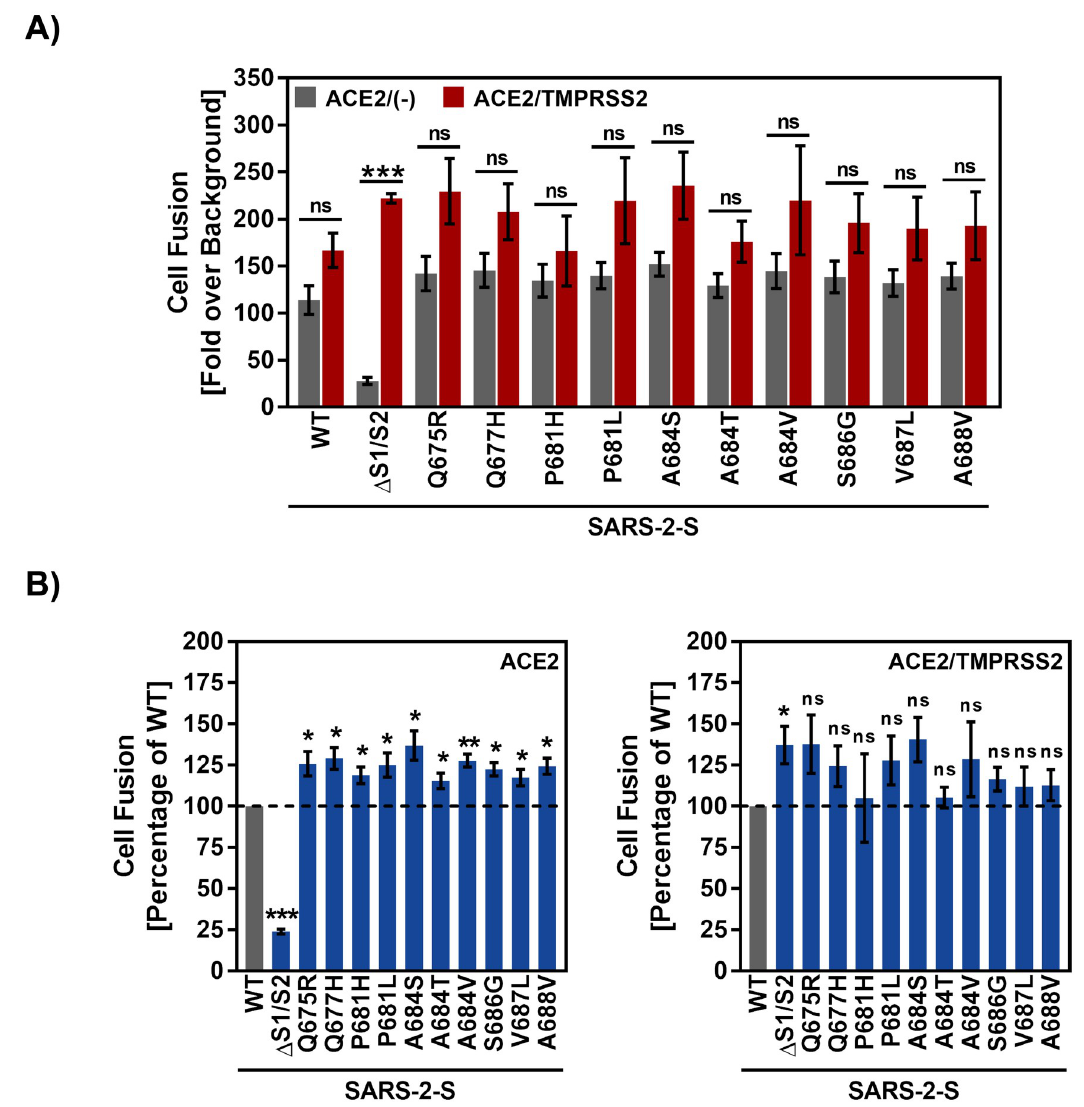
Fig 3. SARS-CoV-2 mutants mediate robust cell-cell fusion. A) Effector cells cotransfected with Vp16-Gal4 transactivator plasmid and pCG1 empty vector (negative control) or expression plasmids for the indicated S proteins were co-cultured with target cells cotransfected with Gal4-TurboGFP-Luc reporter plasmid and either ACE2 expression plasmid alone or in combination with TMPRSS2 expression plasmid. At 24 h post transfection, luciferase activity in cell lysates was measured. Displayed are the average data from four independent experiments (each performed with biological triplicates) where cell-cell fusion was either normalized against the assay background (A; fold over background, set as 1) or against WT SARS-CoV-2 S (B; percentage, set as 100%). Error bars represent the SEM. Statistical significance was analysed by two-tailed Student’s t-test with Welch’s correction (p > 0.05, not significant [ns], p � 0.05, � ; p � 0.01, �� ; p � 0.001, ��� ). WT =